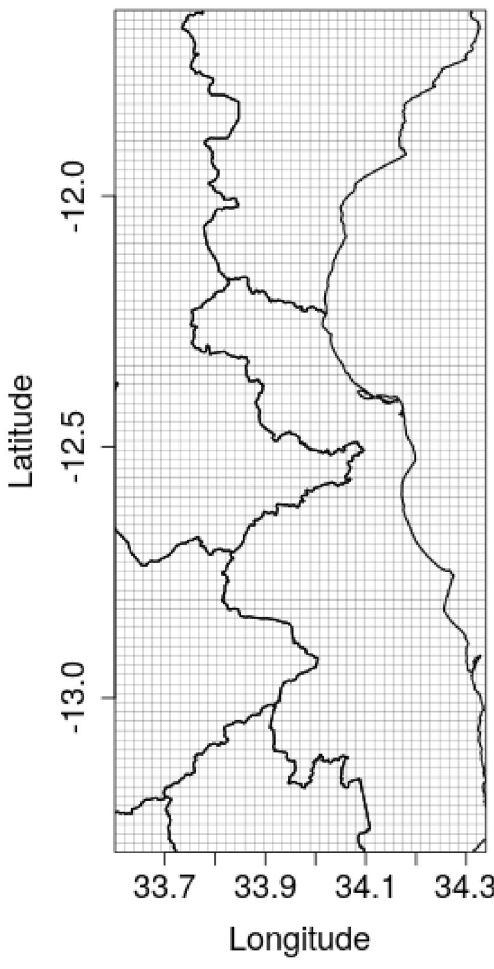
Figure 20. Regular grid for prediction, cropped to the northwest of Malawi. Prediction grids were of equivalent resolution in Uganda and